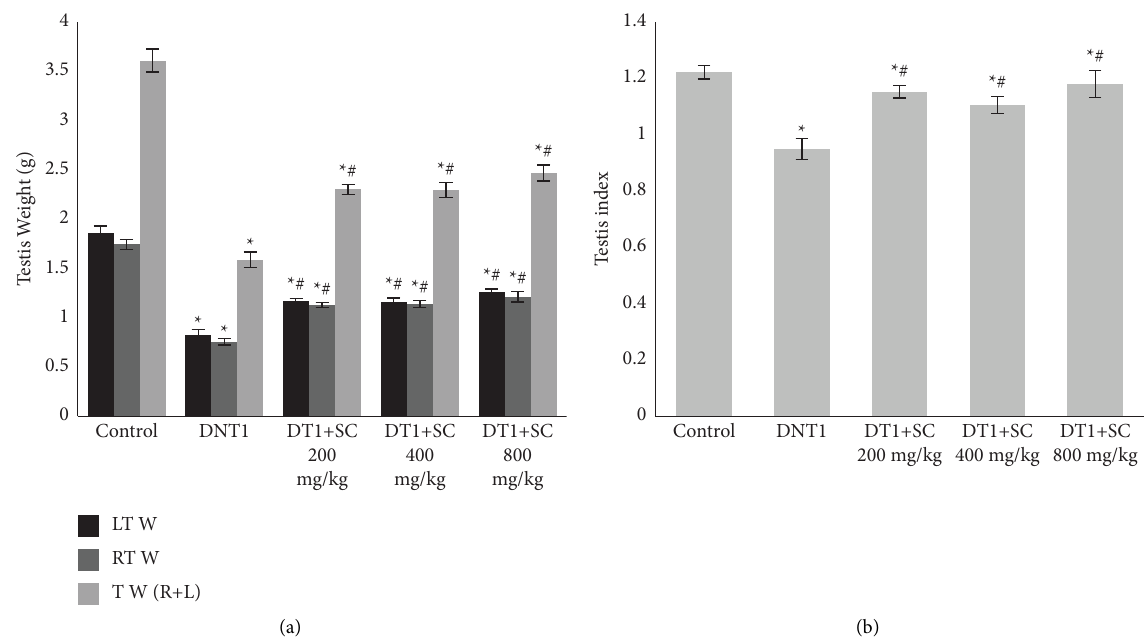
Figure 3: Testis weight and testis index of animals. (a) mean testis weight, (b): mean testis index. Significant differences at p value < 0.05 are shown as not having a common character. Values are shown as Mean ± SEM. star sign ( ∗ ): difference with control, hashtag sign (#): difference with DNT1, plus sign (+): difference with DT1+ SC200mg, multiplication sign ( × ): difference with DT1+SC400